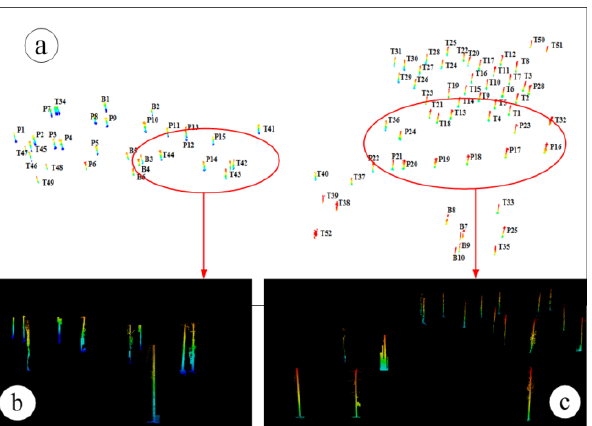
Table 2: Number and type of PSO detected in the study